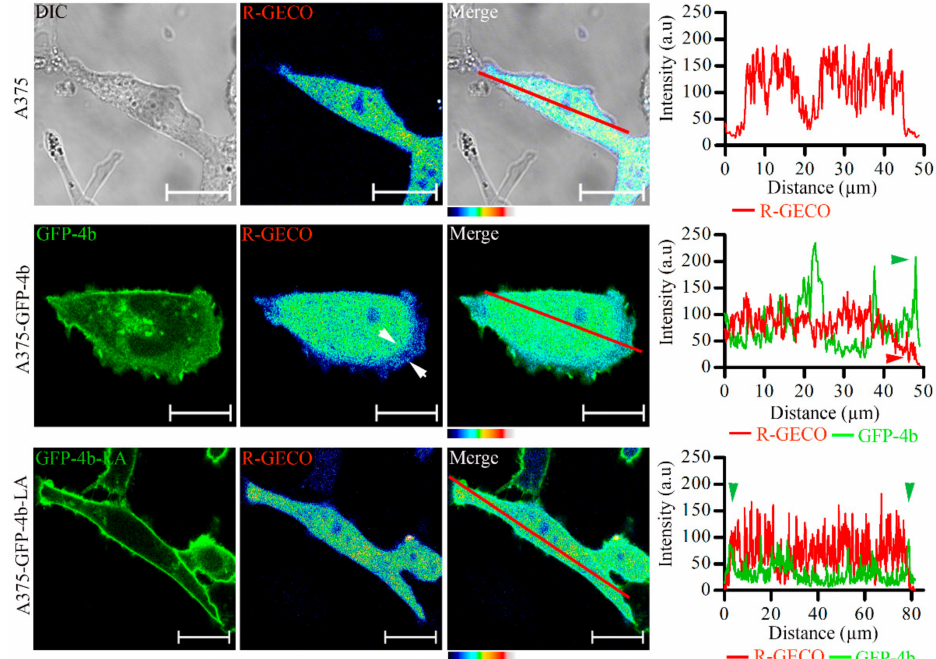
Figure 10. Proper trafficking of PMCA4b is needed to maintain a front-to-rear Ca 2+ concentration gradient in A375 cells. A375, A375-GFP-PMCA4b, and A375-GFP-PMCA4b-LA cells were transfected with the CMV-R-GECO1 plasmid. Cells were fixed and confocal microscopy images were taken. Low Ca 2+ levels are indicated by the arrowheads at the leading edge of A375-GFP-PMCA4b cells. Scale bar, 20 µ m. Graphs represent GFP-PMCA4b (green) and R-GECO intensity (red) profiles for the line (red) drawn along the cells on the confocal images. Arrowheads show the GFP signal at the cell periphery. Line plots were drawn and analyzed using the ImageJ